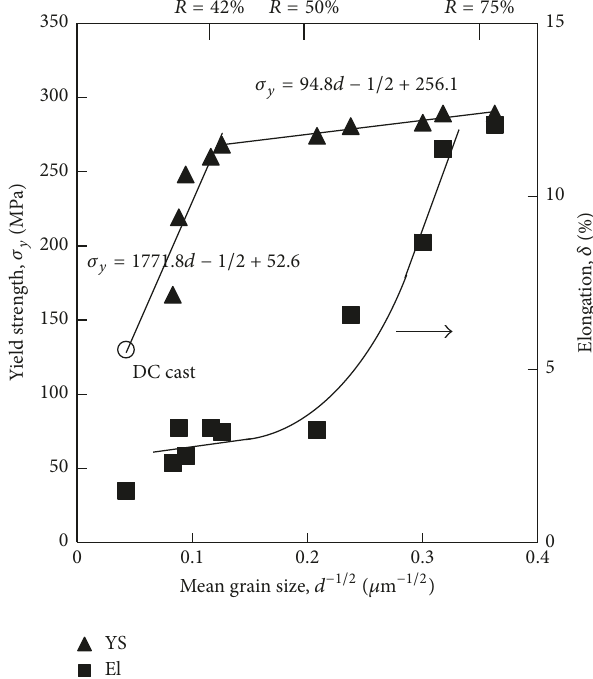
Figure 3: Hall-Petch plots and changes in the elongation as a function of (mean grain size) −1/2 under various reduction ratios of the hot-rolled AZX811 alloy. The yield stress of the DC alloy and the total reduction ratio ( R ) are indicated by the open